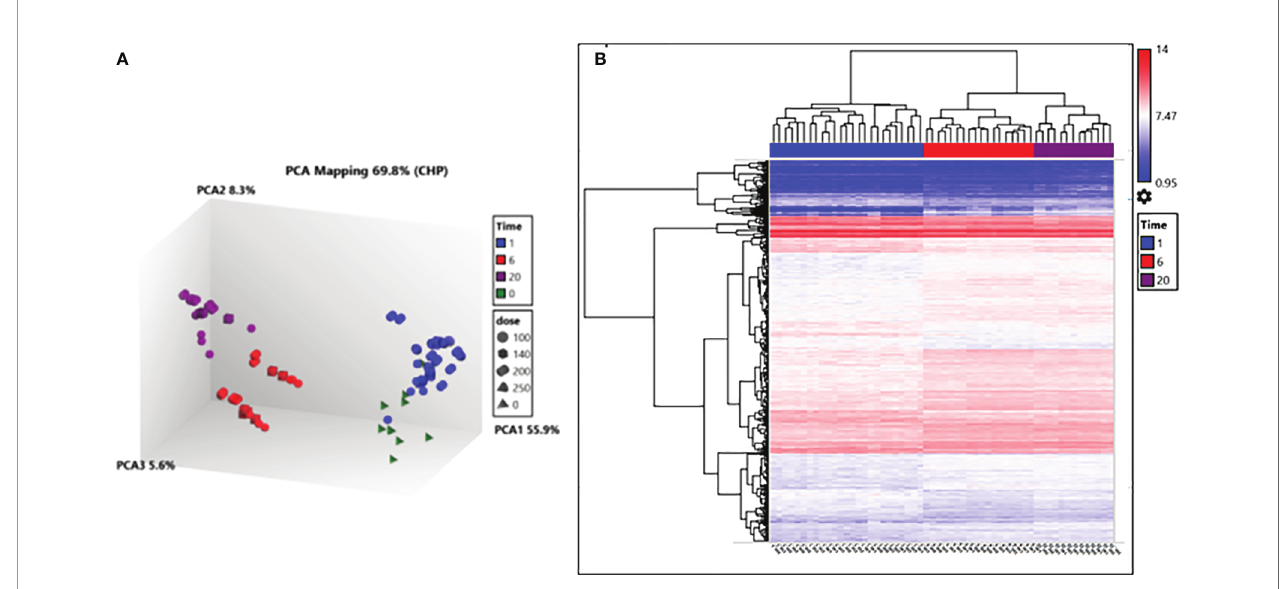
FIGURE 4 | Transcription analysis of irradiated parasites using the TrypMS array. (A) PCA mapping separated samples according to time post-irradiation. (B) Hierarchical clustering of deferential gene transcripts according to time and further sub clustered using the gene ID. Fold change (FC) cut-off points of > 2 and < 2 were used as the limits for upregulation and downregulation respectively and a gene-level P-value < (ABC; 259 genes on Venn diagram) ( Figure 5C ). Other common differential gene transcripts were observed between 140Gy:100Gy (AB), 200Gy:100Gy (AC), and 200Gy:140Gy (BC) of 25, 36, and 59 respectively. The different doses also had unique differential gene transcripts with 102 for 100Gy, 38 for 140Gy, and 103 for 200Gy irradiation samples. An exhaustive comparison between differential gene transcripts across different doses and times post-irradiation is listed in Table 1 . All doses showed a higher total difference at 20 hours apart from 200Gy which had its peak of differential expression at 6 hours.